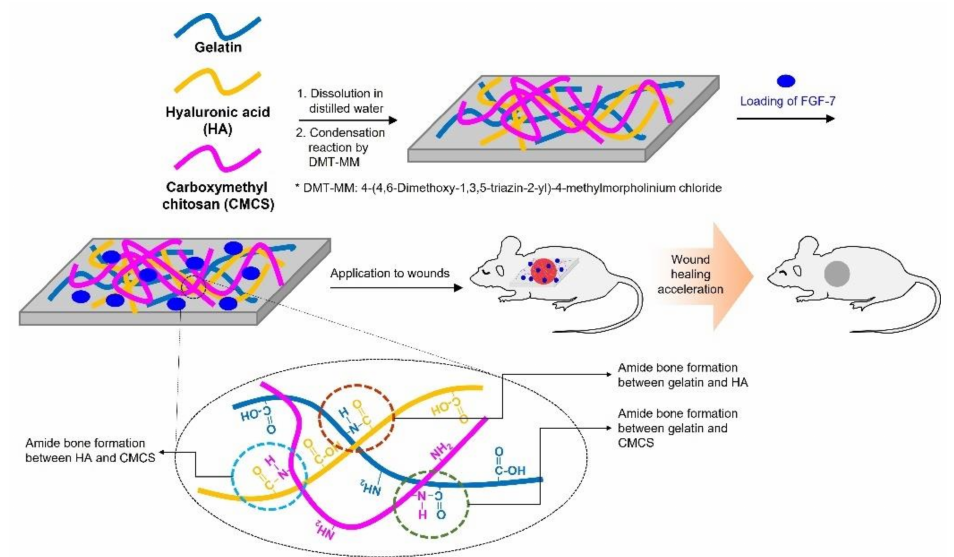
Figure 1. Schematic illustration of FDs made of gelatin, HA, and CMCS containing various concen- trations of FGF-7 and amide bond formation among the polymers by condensation reaction. The amide bonds were formed by condensation reactions between the carboxylic group of gelatin and the amine group of HA, between the carboxylic group of HA and the amine group of gelatin, and between the carboxylic group of HA and the amine group of